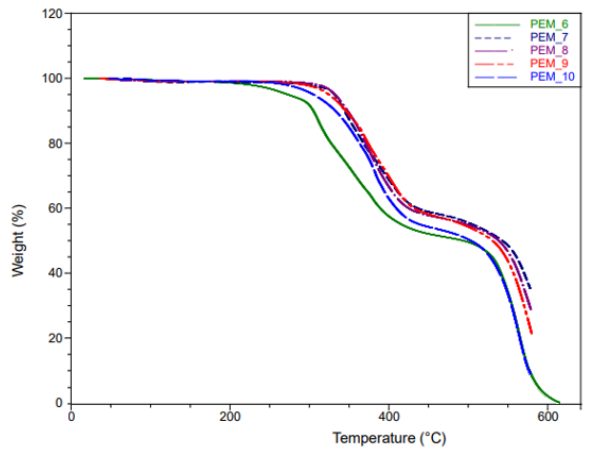
Figure 6. TGA curves of PEM_6–PEM_10.